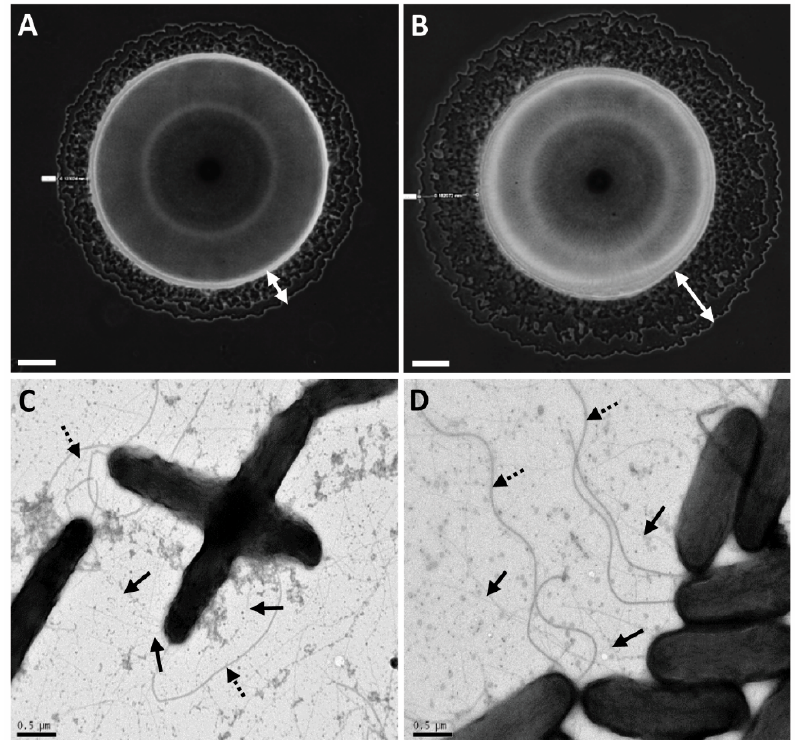
Figure 2. Twitching motility and type IV pilus (T4P) formation of A. citrulli M6 and an M6 mutant disrupted in gene APS58_1588 (M6 -lip1 - ). Images of bacterial colonies of M6 ( A ) and M6- lip1 - ( B ) seen by light microscopy after 48 h of growth on NA plates at 28 °C. Typical haloes surrounding the bulk colonies (indicated by the white double arrows) are formed by bacteria migrating via twitching motility. Pictures were taken using an Axio Scope light microscope equipped with a DXM1200F digital camera. Transmission electron microscopy observations of M6 ( C ) and M6- lip1 - ( D ). The strains were observed in a FEI Tecnai-12 electron microscope after growth on NA at 28 °C for 48 h. Solid and dashed arrows indicate polar flagellum and T4P, respectively. Bars at the bottom of each panel: 100 μ m for ( A , B ); and 0.5 μ m for ( C , D ).